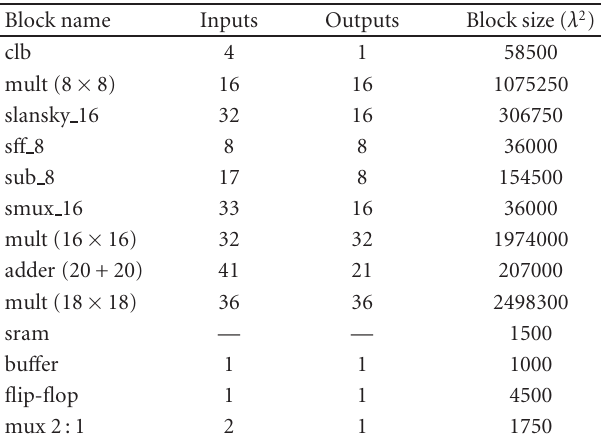
Table 4: Area of di ff erent blocks of three